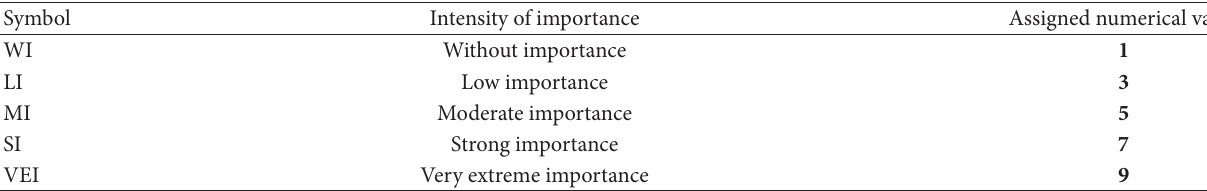
Table 2: The fundamental scale score.